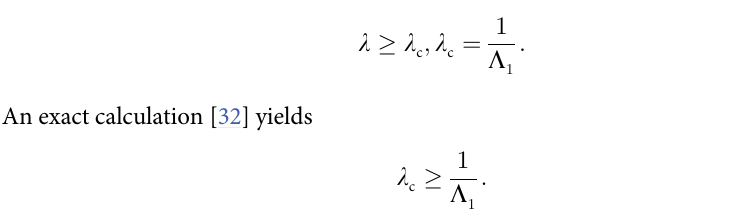
S1 Fig. The total number of reviews for each month. S2 Fig. Degree correlation curve. Plot of the average degree of the neighborhood of degree k nodes as a function of k. The green marks correspond to the observed networks, whereas the purple ones correspond to the randomized network preserving the degree distribution. (A) and (B) show the average degree of neighbors of degree k nodes for FCSWs and MCs, respec- tively. The assortativity coefficient is -0.181. This negative correlation indicates that popular FCSWs are shared by many infrequent MCs. (C) and (D) show the same analysis for the FCSW–FCSW and MC–MC projection networks (right panel in Fig 2A). The assortativity coefficients were positive, suggesting that active MCs tend to review common FCSWs,